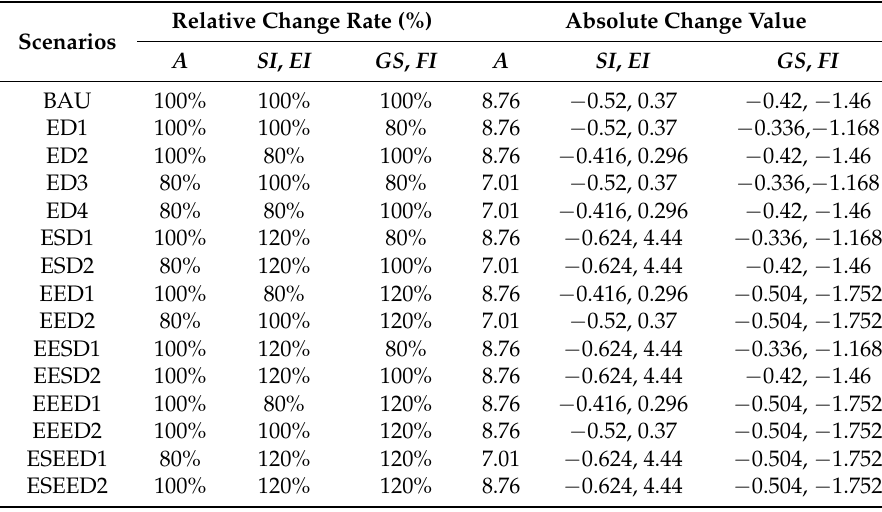
Table 6. Growth rate (%) assumptions under different scenarios and predicted emissions.